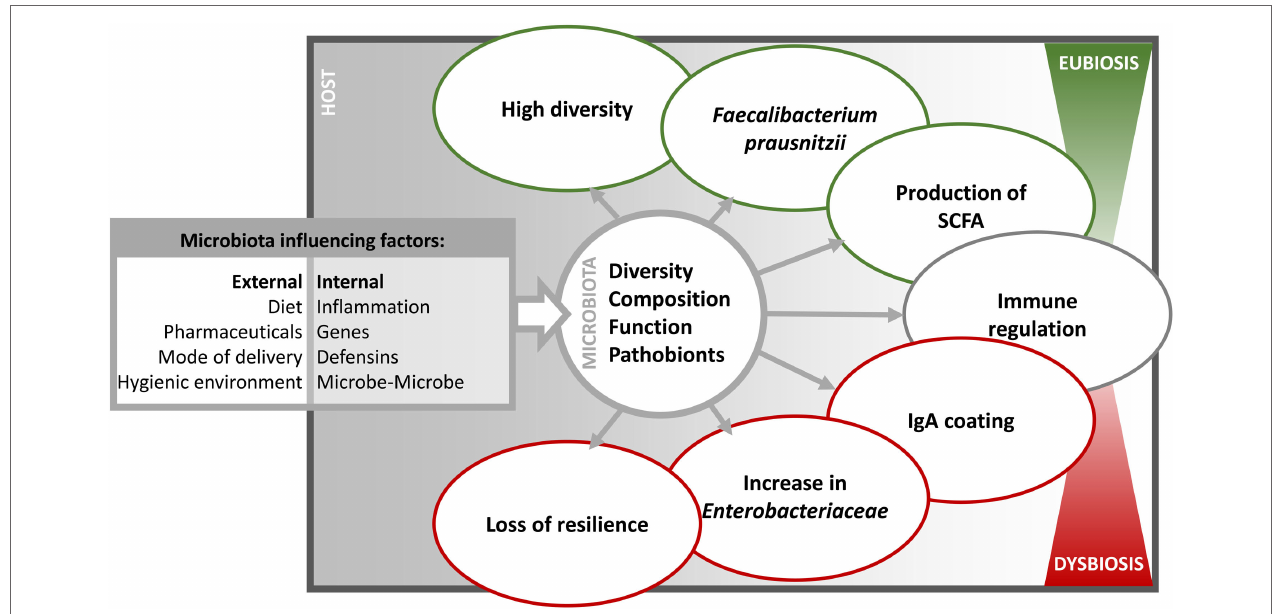
FiGURe 1 | The different influencing factors and characteristics of dysbiosis . The intestinal microbiota is influenced in diversity, composition, function, and prevalence of pathobionts by internal and external factors. Consequently, the microbiota varies in immune relevant characteristics and thereby shifting from a eubiotic to a dysbiotic